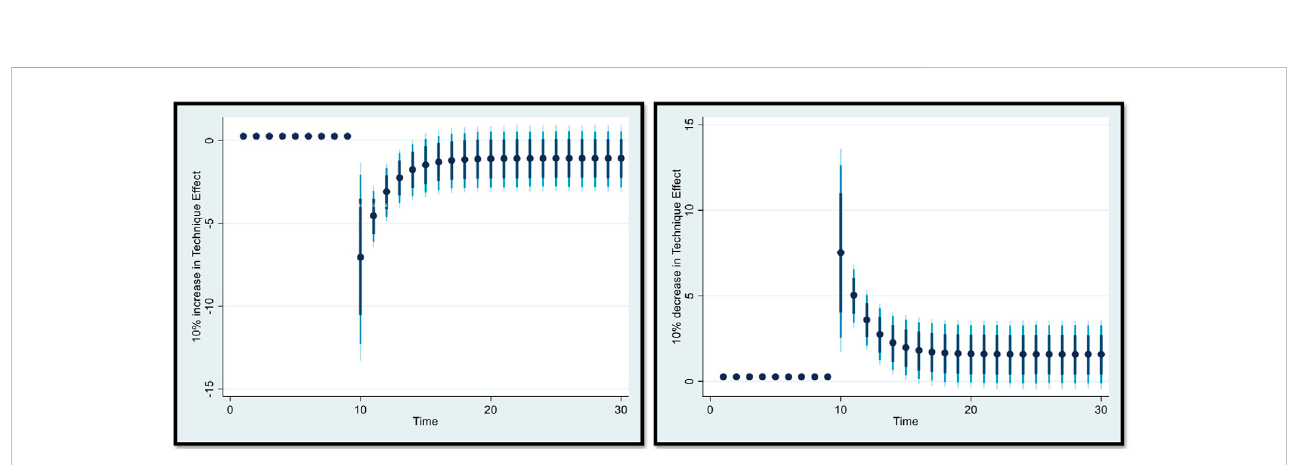
FIGURE 2 Impulse response plot for technique effect and CO 2 emissions. An increase and a decrease of 10% in technique effect and its effect on CO 2 emissions, where dots denote the average prediction value. The dark blue to light blue lines show 75%, 90%, and 95% con fi dence intervals,